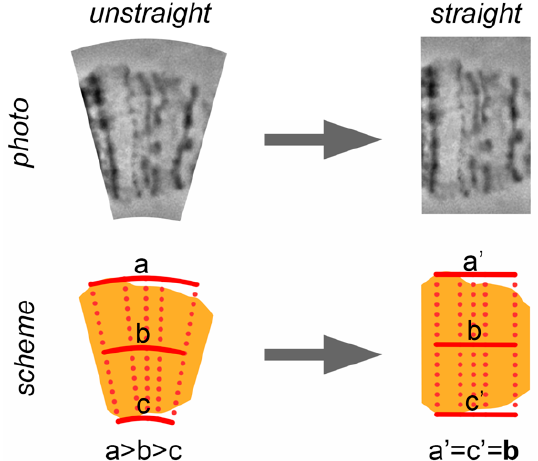
Figure 5. A principle of chromosome straightening. The distances between marginal points of the different bands (a, c) became equal to the distance between the axial points of the bands (b) after chromosome straightening.